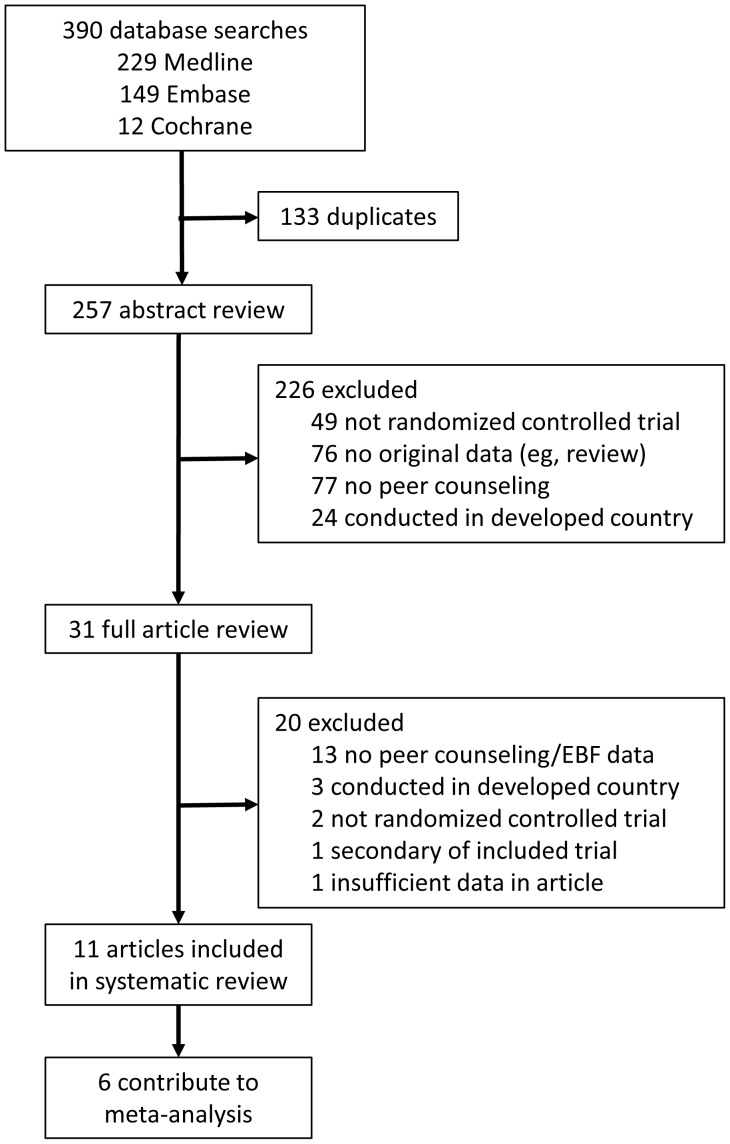
Flow diagram of included and excluded studies.